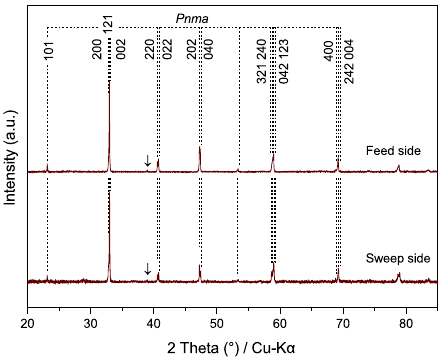
Figure 8. XRD patterns of the spent Pr 0.5 Sr 0.5 (Cr,Mn,Fe,Co,Ni)O 3– δ membrane after the experiment displayed in Figure 7 (CO 2 + Ne sweep at 1223K for 46.2h and He + Ne sweep for 2h). Reflections were indexed according to the results of Rietveld refinement using PrCrO 3 (ICSD 251098) as the starting structure. Arrows: Bragg positions of CaCO 3 (ICSD 52151) from XRD sample